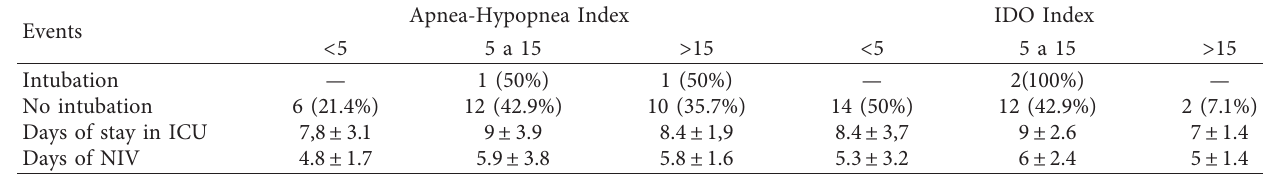
Table 3: Intubation events according to Apnea-Hypopnea and Deoxygenation